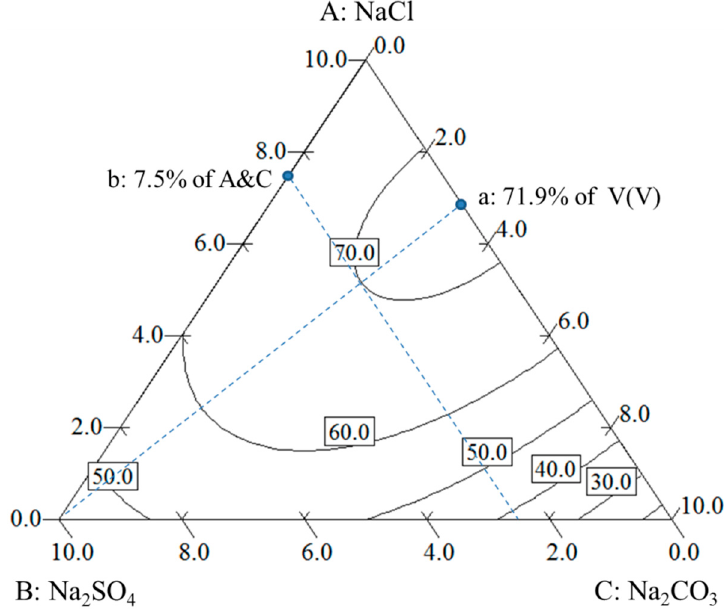
Figure 8. Contours among NaCl, Na 2 SO 4 , and Na 2 CO 3 for V(V) of roasted slag.